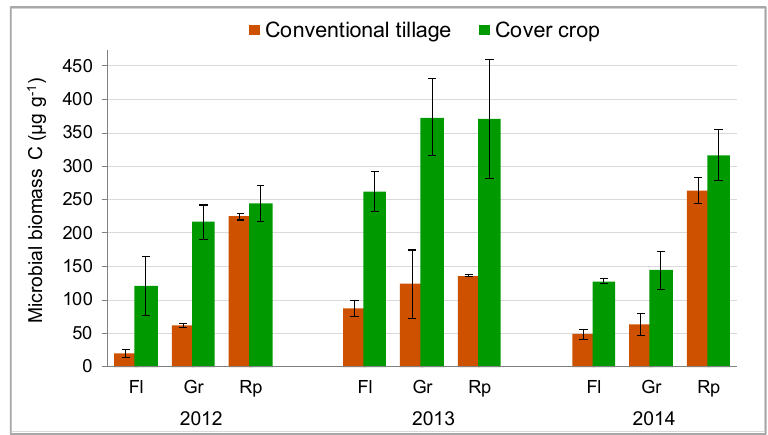
Figure 3. The trend of microbial biomass carbon of soil subjected to conventional tillage or cover crop during flowering (Fl), fruit growth (Gr) and ripening (Rp) in the three years of experimentation. The bar on each column indicates the standard deviation (n = 3).